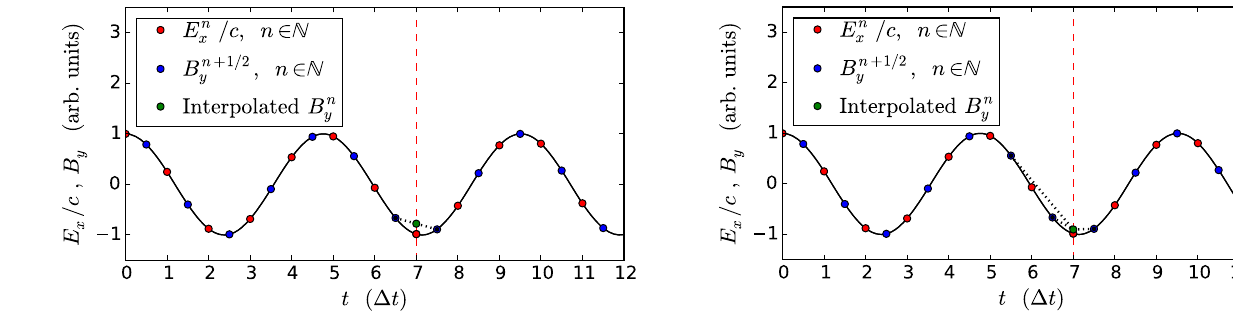
FIG. 8. Schematic representation of the third-order accurate 7. Schematic evolution of the E x and B y fields for a interpolation method. This method is more accurate than the sinusoidal wave, in a PIC simulation. On the Yee lattice, the n þ 1 standard second-order accurate interpolation method, and thus 2 y (blue dots) lie exactly on discrete fields E n x =c (red dots) and B the interpolated field lies closer to the sinusoid than in Fig. 7. the same sinusoid. However, when interpolating the B y field to an integer time (dashed red line), the interpolated field B n y is not on the sinusoid (green dot), and thus the E x and B y fields do not cancel exactly when computing the Lorentz